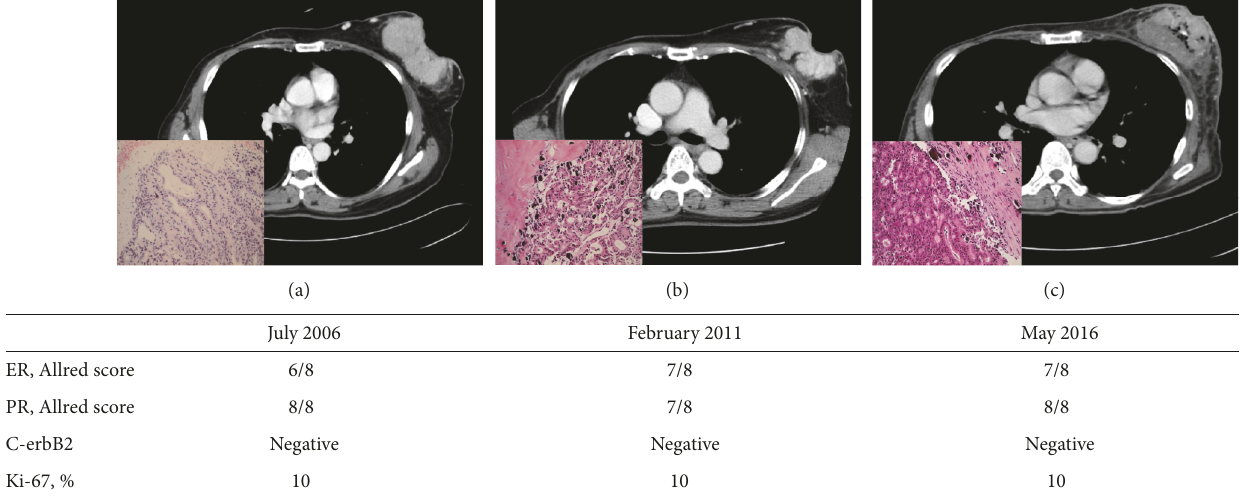
Figure 1: (a–c) The progression of invasive papillary breast carcinoma followed up for 10 years (LM, × 200). ER: estrogen receptor; PR: progesterone